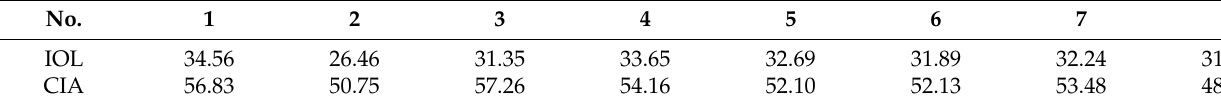
Table 3. The calculation result of chemical weathering index in the study area.